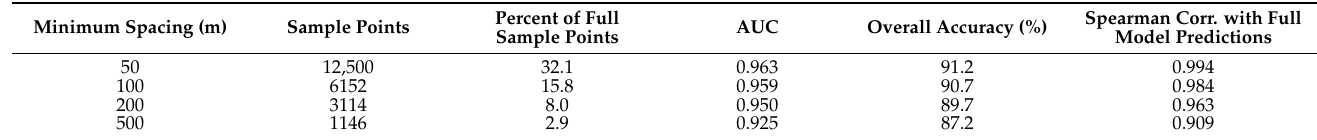
Table 4. Mean results for Model 2 trained with 20 random subsets of the full training dataset with minimum spacing distances of 50 to 500 m. AUC and overall accuracy were calculated with all samples not used for model training. The Spearman rank correlation is calculated by comparing the full and subset model predictions for the entire training